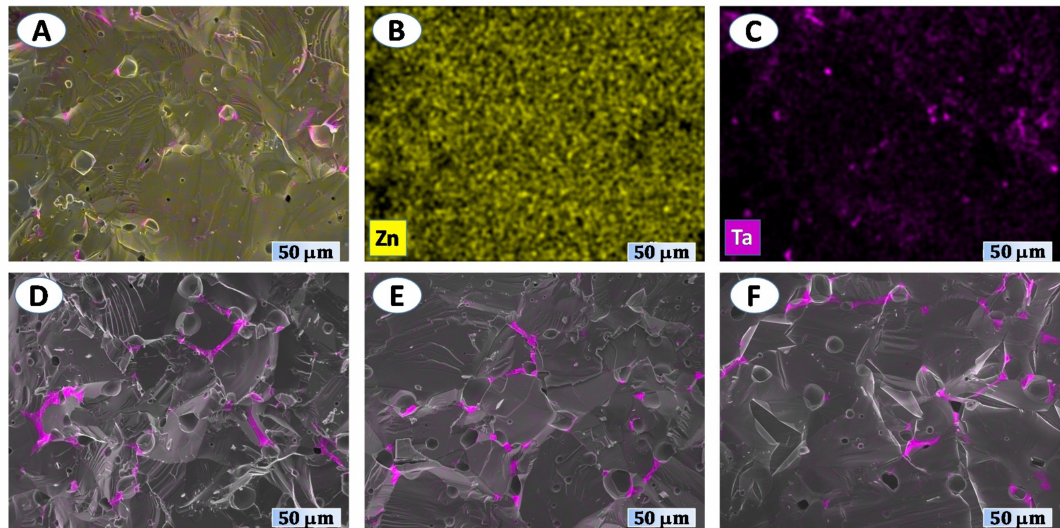
Figure 4. Energy-dispersive X-ray spectroscopy (EDS) mapping results for x = 0.02 ( A – C ), x = 0.04 ( D ), x = 0.06 ( E ) and x = 0.08 ( F ).